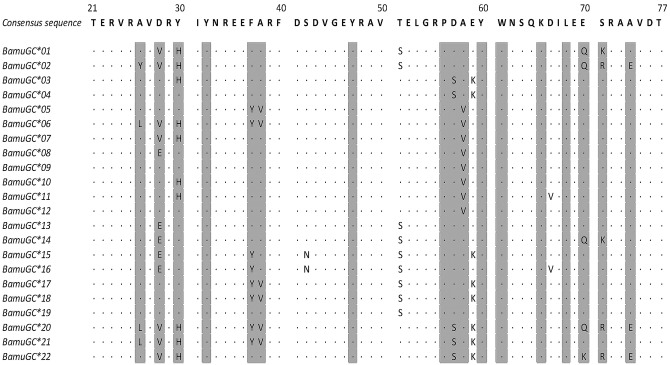
Amino acid alignment of DQB allotypes from B. musculus.The alignment was based on the nucleotide sequences (Fig 1). The identity with the consensus sequence is indicated by a dot (·). Putative PBR sites are shadowed and were assigned according to the three dimensional structure of human and beluga MHC-II molecule structure [9, 31]. The numbers above the consensus sequence correspond to amino acid positions of the human class II beta chain structure [31].